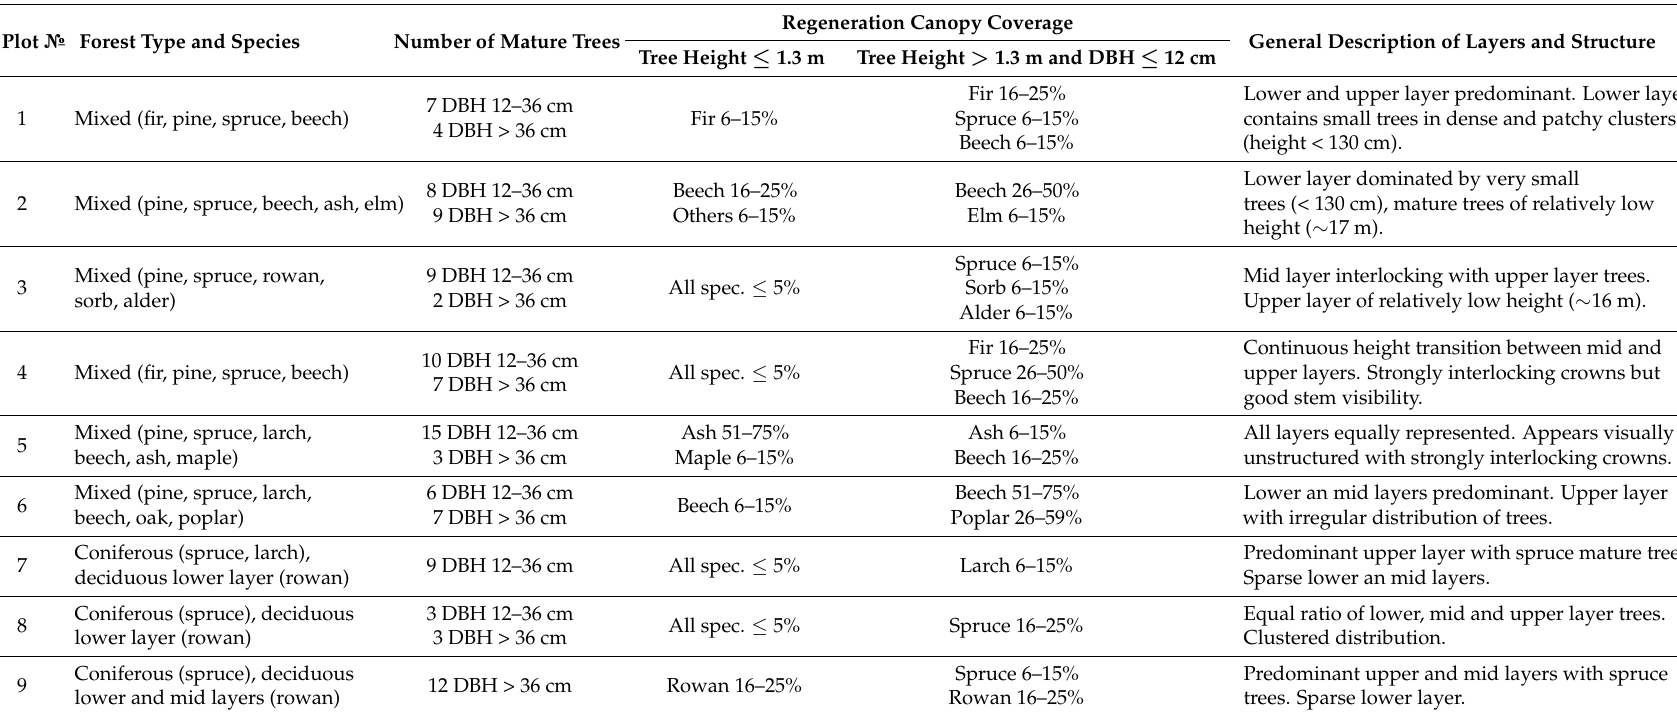
Table 1. Overview of the sample plot characteristics. The table lists forest type and structural forest information, which are critical factors for single tree segmentation.